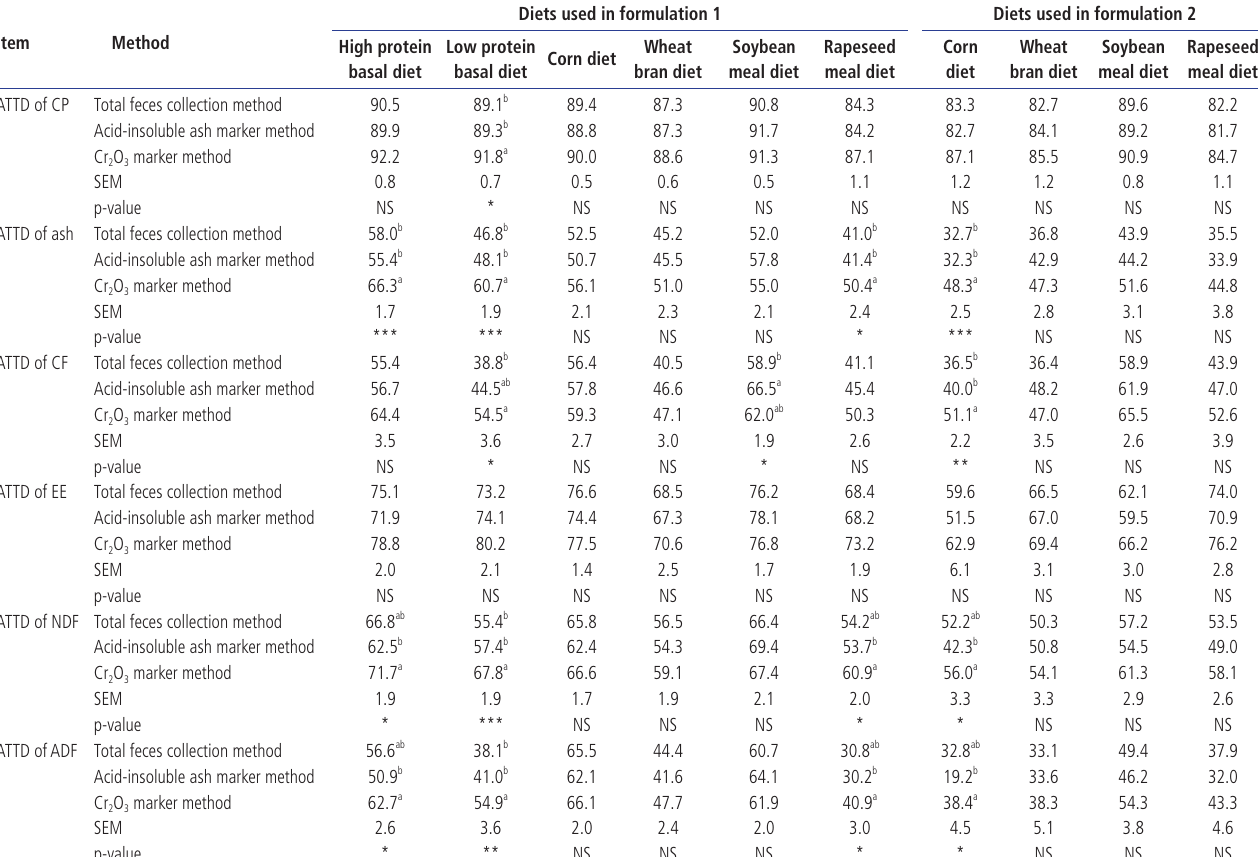
Table 6. Effects of different methods on the apparent total tract digestibility (ATTD) of nutrients in the experimental diets fed to growing pigs (%) 1)